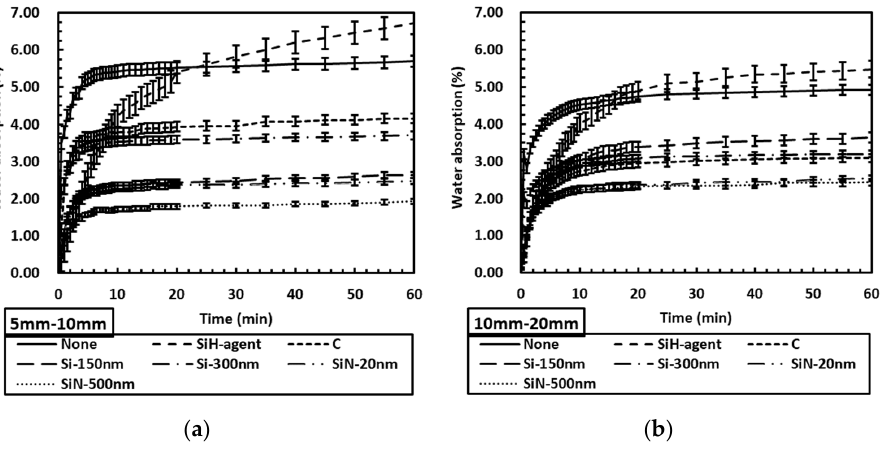
Figure 4. The water absorption of modified recycled coarse aggregate, ( a ) (5–10) mm, ( b ) (10–20)